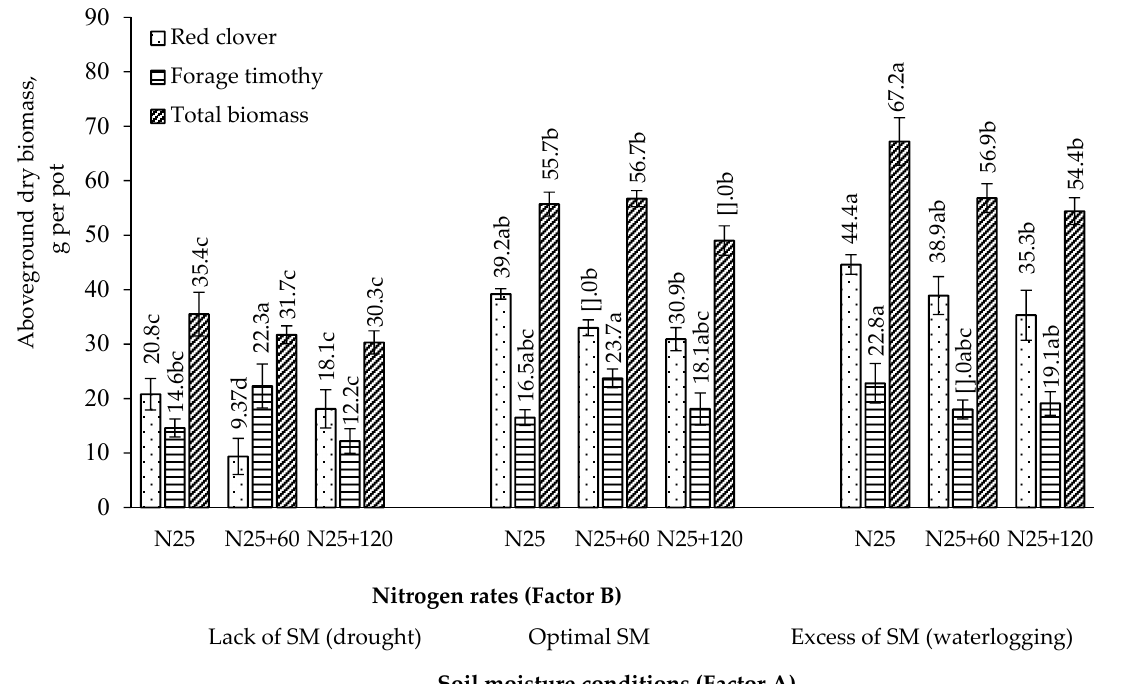
Figure 7. Aboveground dry biomass of red clover and forage timothy mixture. Note, differences between the means of treatments for separate plant species and total biomass, marked by different letters (a, b, c), are significant ( p < 0.05). Whiskers indicate standard errors of the means. SM—soil moisture.